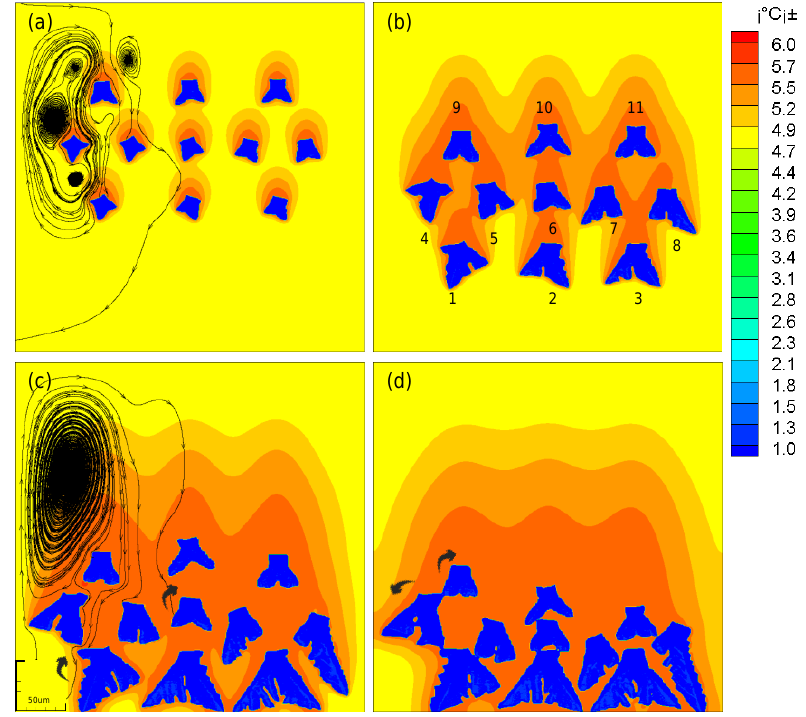
Figure 9. The evolution and concentration distribution of multi-falling-dendrites. ( a ) t 1 = 200; ( b ) t 2 = 500; ( c ) t 3 = 800; ( d ) t 4 = 1200.